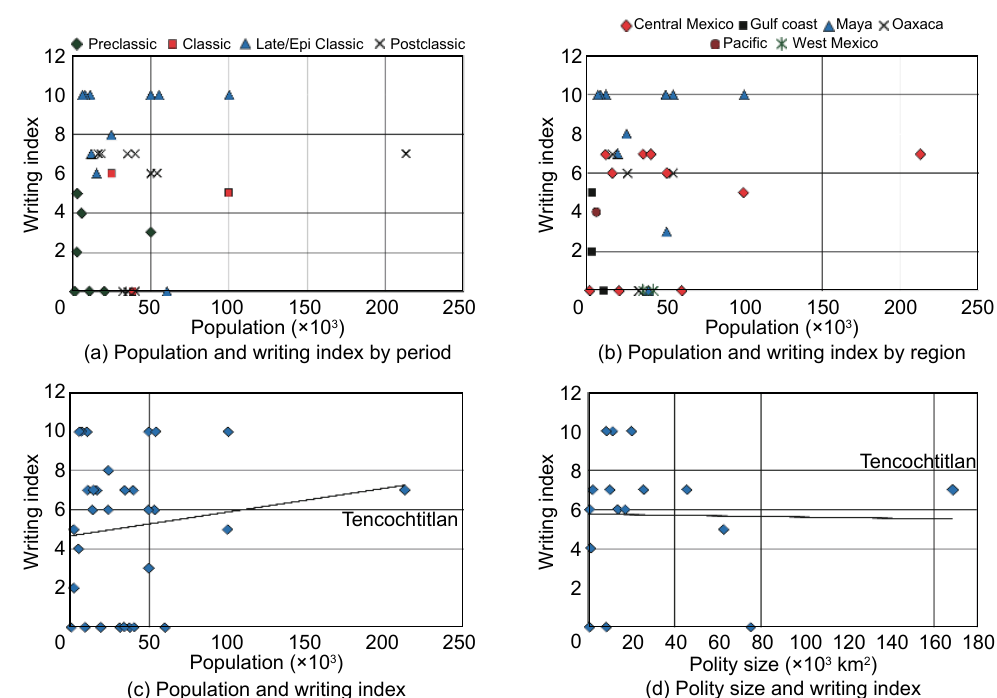
Fig. 5 Population, polity size, and writing